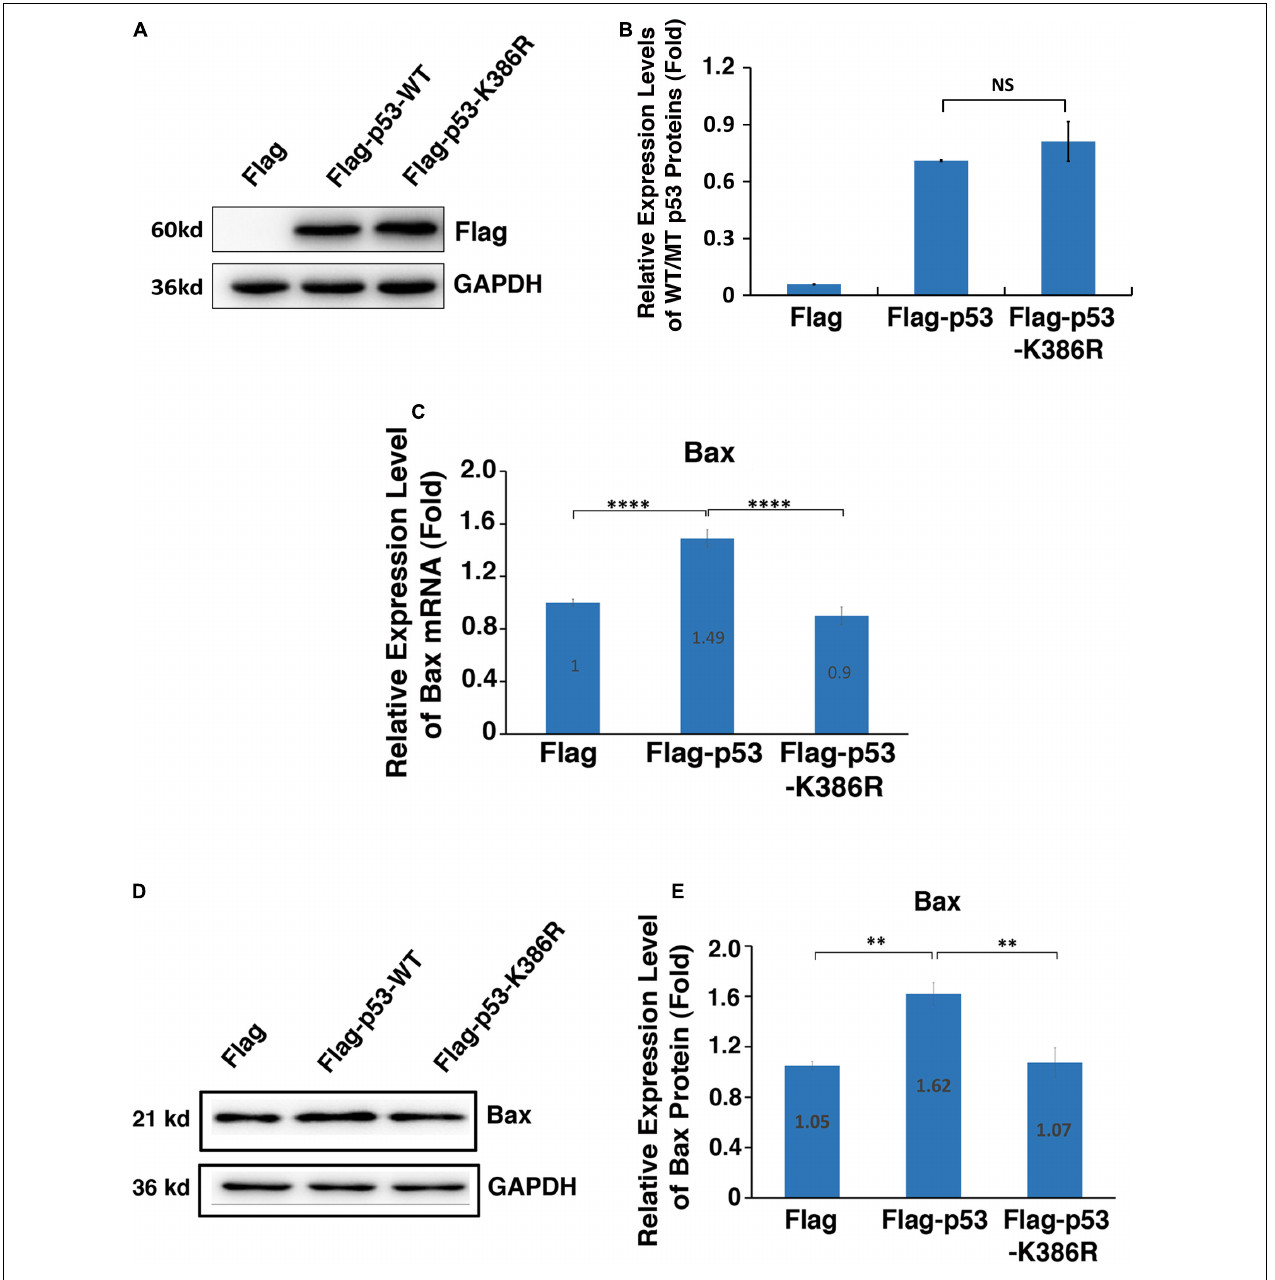
FIGURE 6 | PIAS1-mediated p53 sumoylation at K386 enhances expression of the downstream proapoptotic regulator Bax. p53-KO α TN4-1 cells were transfected with Flag, Flag-p53-WT, or Flag-p53-K386R as indicated. Forty-eight hours after transfection, the mRNA or protein expression levels of exogenous p53 and Bax were analyzed. (A) The protein expression of exogenous p53 in three samples were analyzed by Western blot as indicated. The GAPDH was used as a loading control. (B) Quantification of the Western blot results in panel (A) . (C) The mRNA expression level of Bax in three samples was analyzed by qRT-PCR. Cp values of each sample were normalized with the Cp value of β -actin. (D) The protein expression level of Bax in three samples was analyzed by Western blot as indicated. The GAPDH was used as a loading control. (E) Quantification of the Western blot results in panel (D) . All experiments were repeated three times. Error bar represents standard deviation, N = 3. NS, not significant, ∗∗ p < 0.01, ∗∗∗∗ p <